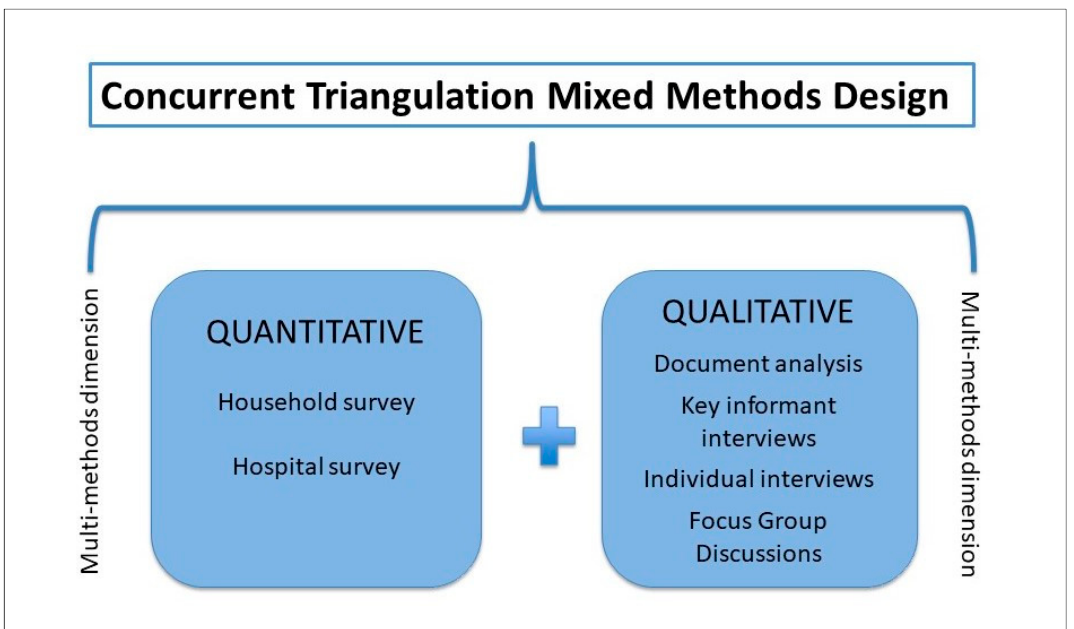
Figure 3. Study Figure 3. Study design.